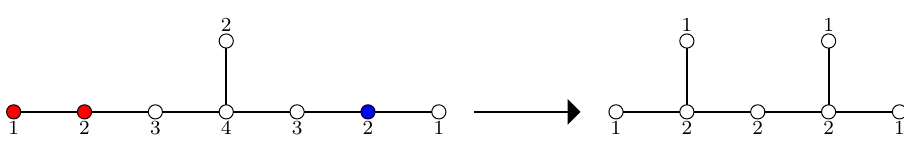
Figure 1 . The SO(12) -preserving FI deformation of the rank 1 E 7 theory. We turn on FI param- eters at the red nodes, and we indicate in blue the node of the E is connected to a higgsed node. The extra U(1) node is coupled to the blue node